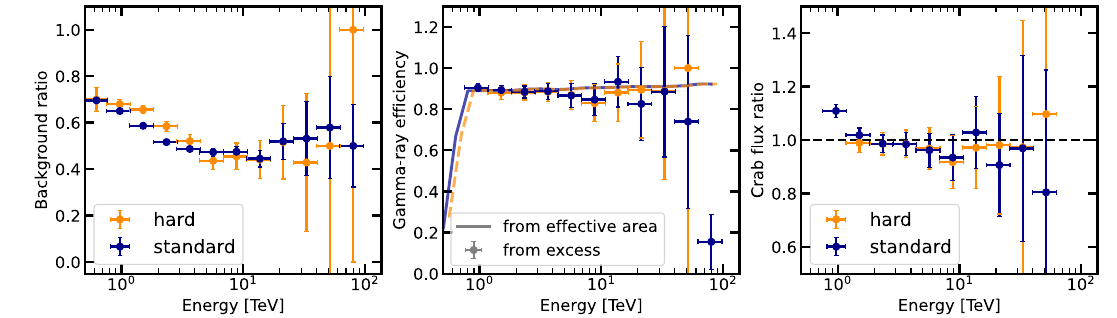
Fig. 5 Verification of the performance using data from the Crab Neb- ula. All ratios shown in this figure are computed as the quantity after applying the ABRIR cut divided by the same quantity before the cut. Left :RatioofbackgroundcountswithandwithouttheuseofABRIRfor both the standard (dark blue) and hard (orange) cuts. Middle : Gamma- ray efficiency computed as the ratio of the resulting effective area for